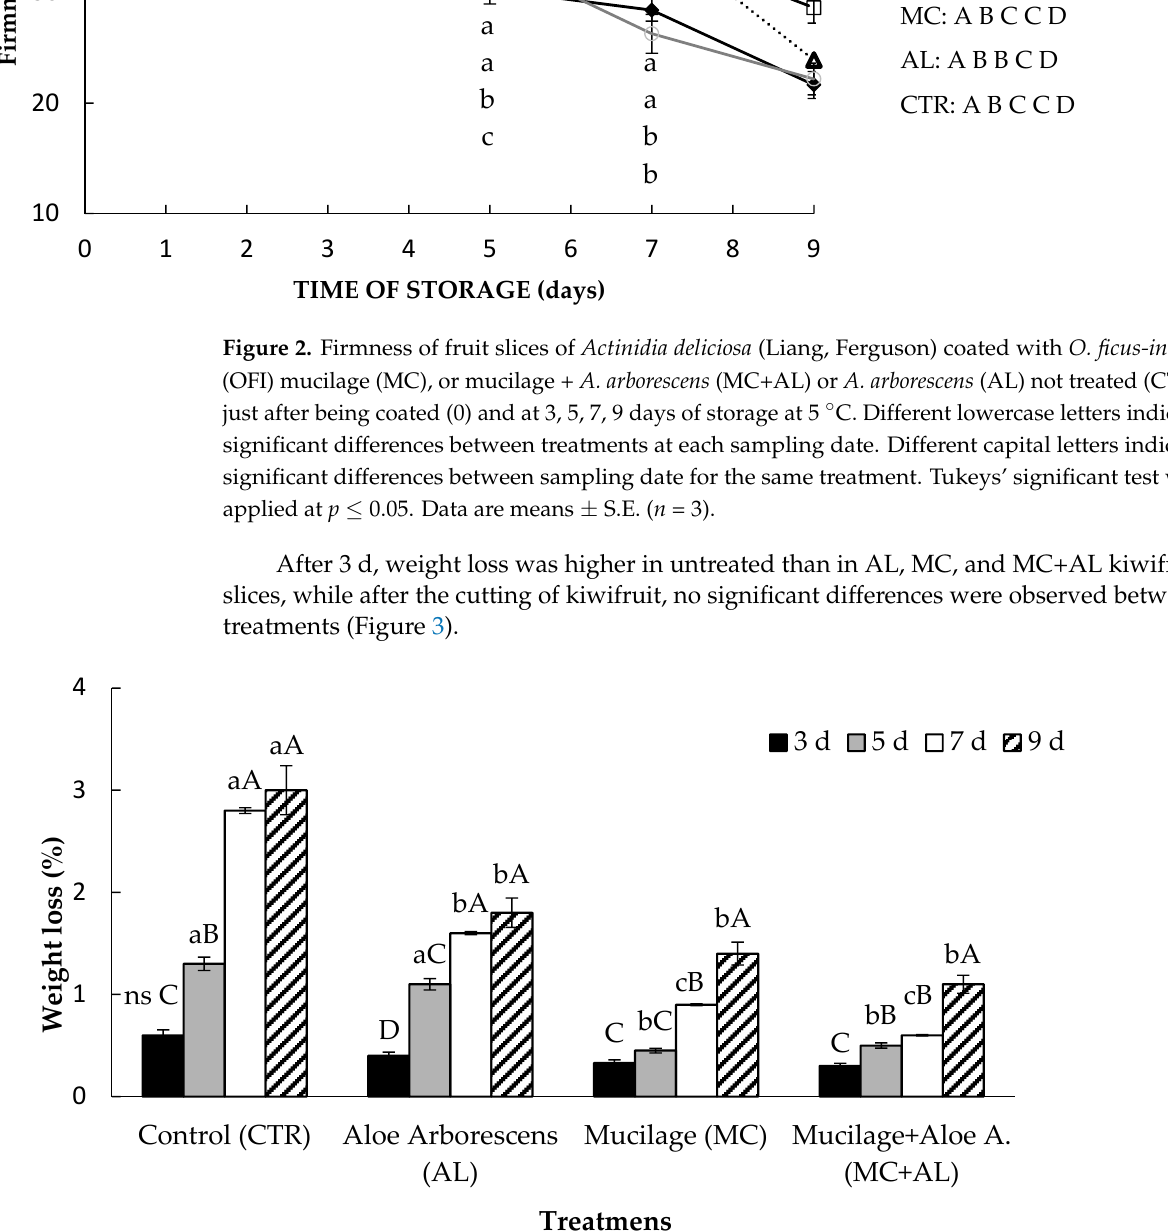
Figure 3. Weight loss (%) of fruit slices of Actinidia deliciosa (Liang, Ferguson) coated with O. ficus-indica (OFI) mucilage (MC), or OFI mucilage (MC), or mucilage + A. arborescens (MC+AL) or A. arborescens (AL) not treated (CTR), just after being coated (0) and at 3, 5, 7, 9 days of storage at 5 °C. Different lowercase letters indicate significant differences between treatments at each sampling date. Different capital letters indicate significant differences between sampling date for the same treatment. Tukeys’ significant test was applied at p ≤ 0.05. Data are means ± S.E. (n = 3).